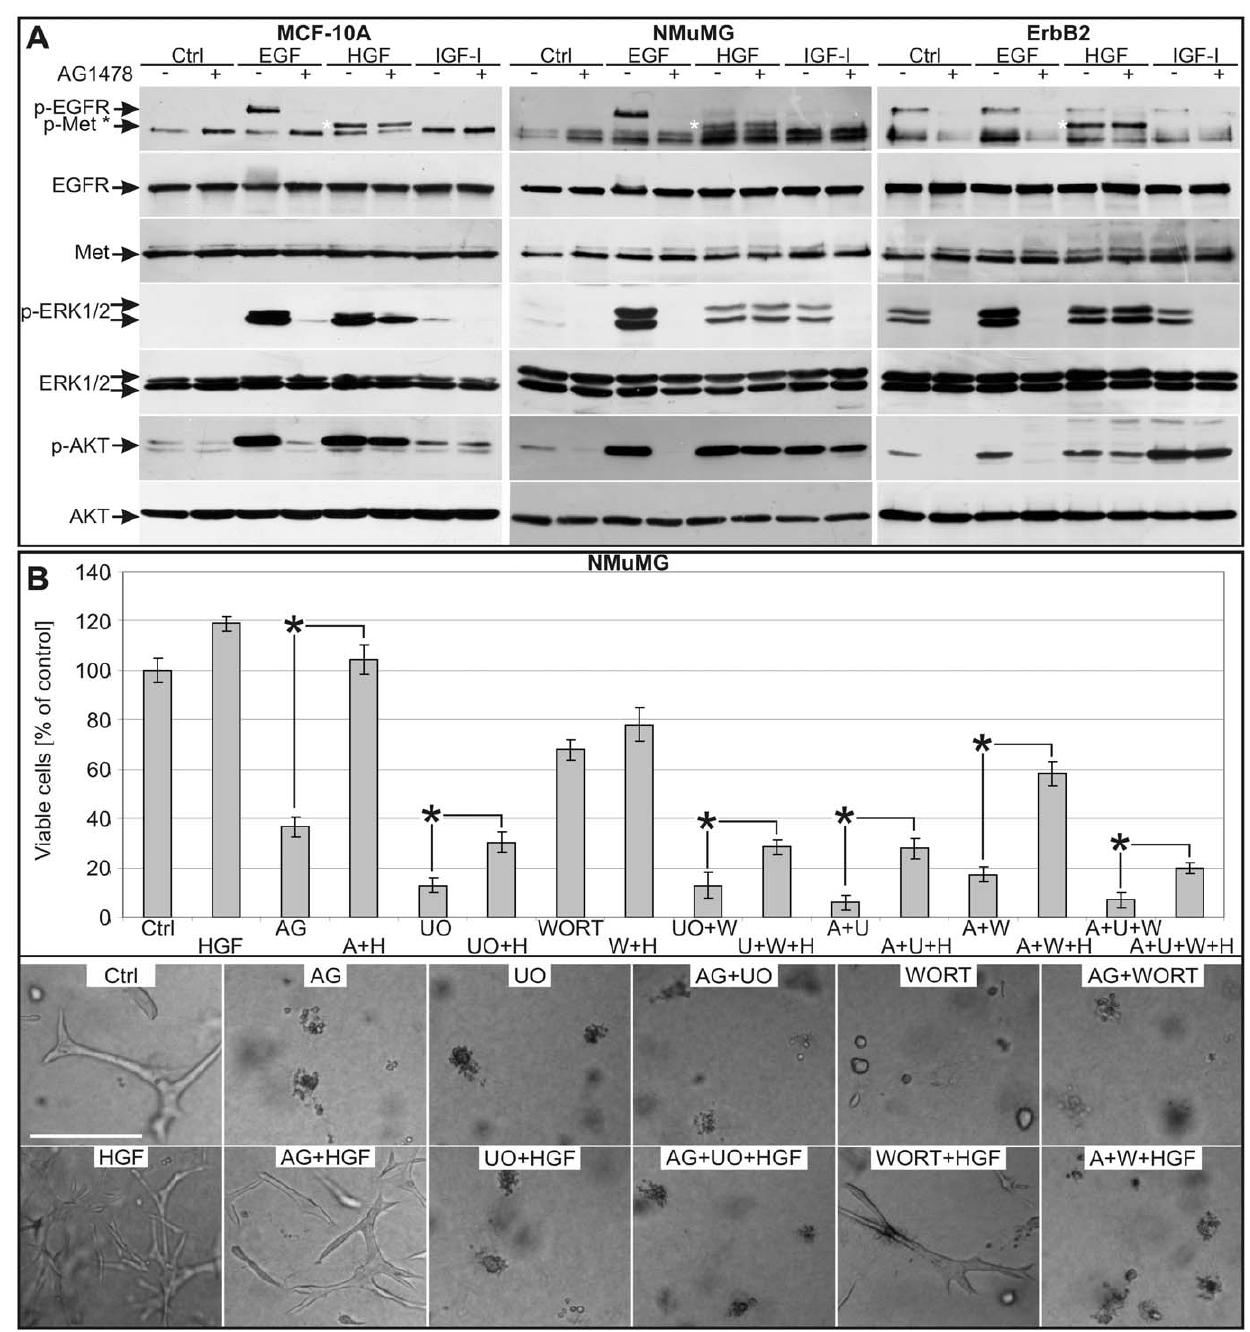
Figure 5. HGF activates Met, ERK1/2 and AKT in EGFR inhibited mammary cells: roles for ERK1/2 and AKT pathways. A. Western-blot analysis of the EGFR, Met, ERK1/2 and AKT phosphorylation status in MCF-10A and NMuMG cells and ErbB2 tumor cells cultivated in starving medium for 16 h and then treated with the RTK inhibitors AG1478 (250 nM, 1 h) before adding the indicated cytokines (10 min; EGF 10 ng/ml, HGF 10 ng/ml, IGF-I 100 ng/ml). B. Viable cell count by trypan-blue exclusion staining at 48 h of NMuMG cells cultivated in growth medium and the indicated inhibitors (AG/A=AG1478 250 nM; UO/U=UO126 15 m M; WORT/W=wortmannin 100 nM) in presence or absence of HGF 10 ng/ml (H). Untreated control (Ctrl) was set to 100%. %. Columns, mean (n=6); bars, S.E.M. *P , 0.05. C. Representative pictures of NMuMG cells grown in collagen gels for 4 days in growth medium with the indicated factors (concentrations as in B; bar =250 m m).